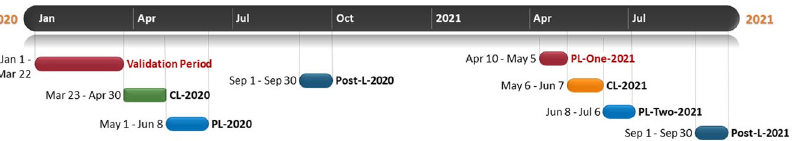
Fig. 1 The timeline depicting different phases of lockdowns in wave one in 2020 and wave two in 2021 (CL complete lockdown, PL partial lockdown, Post-L